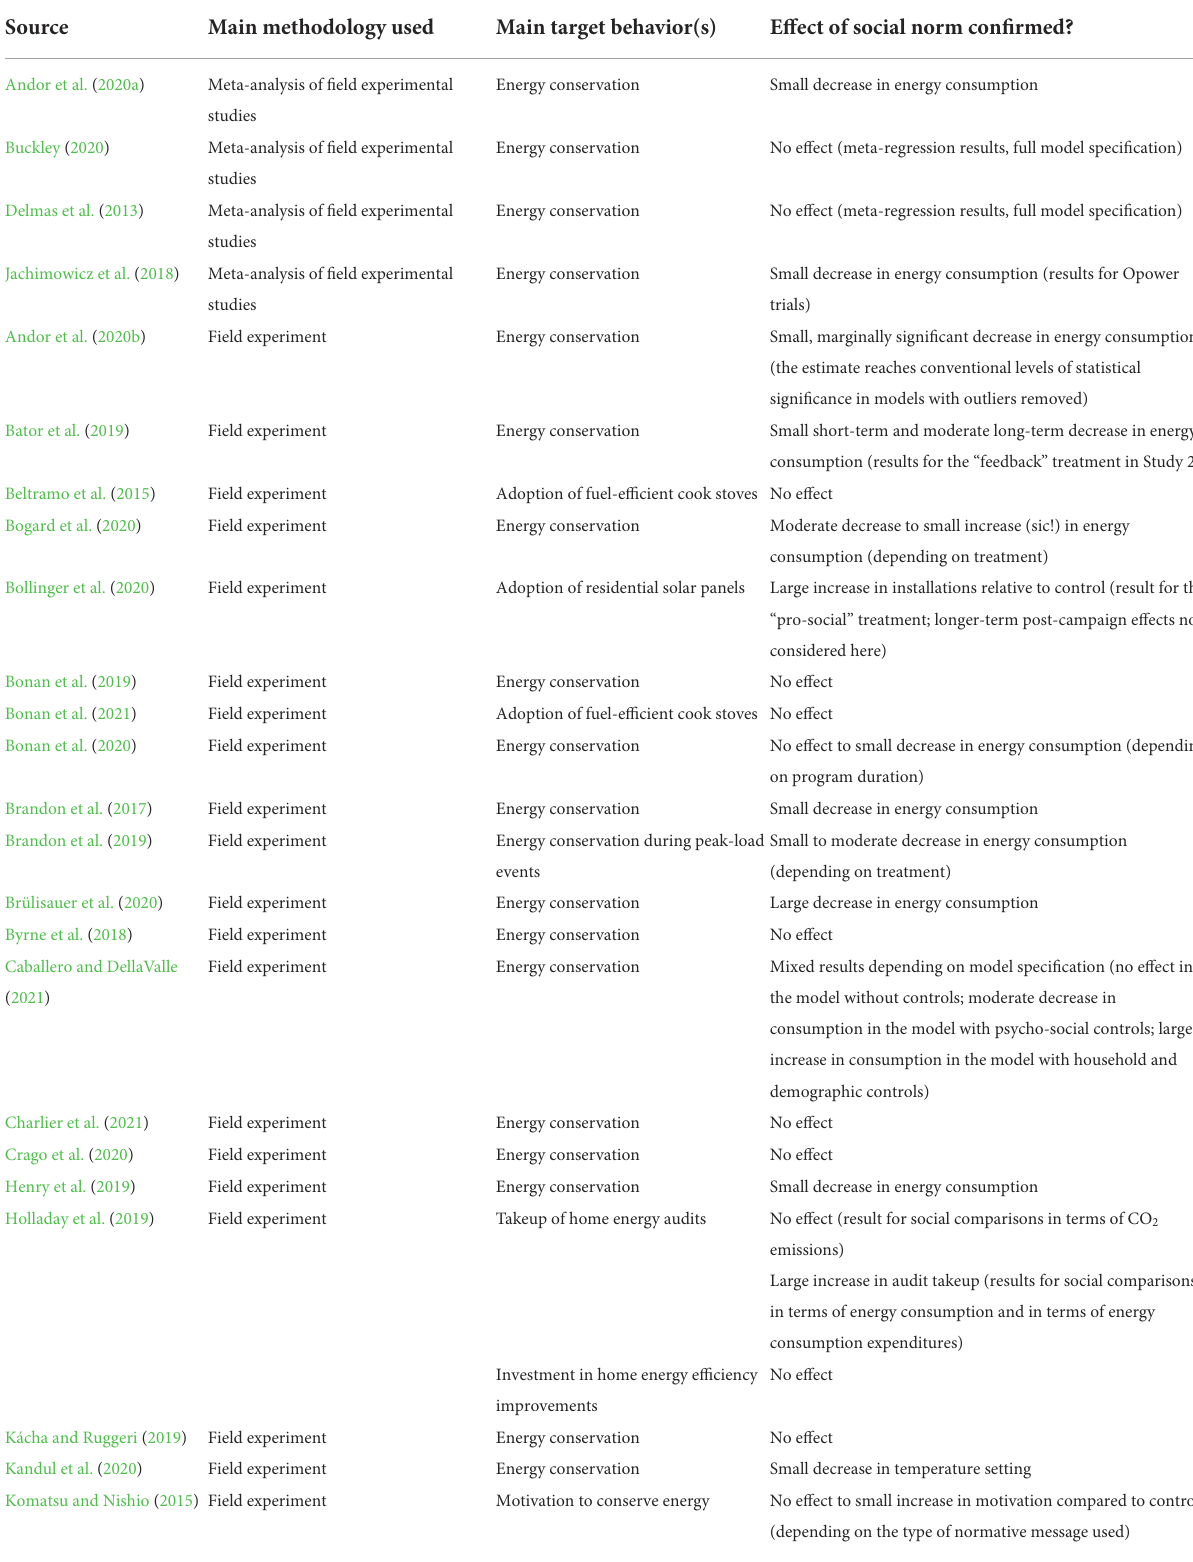
TABLE 1 Overview of former research—social